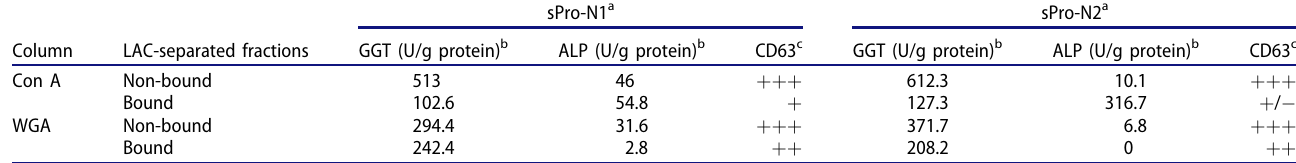
Table 1. Surface-associated markers of seminal prostasomes from normozoospermic men separated by lectin-affinity chromatography. Column